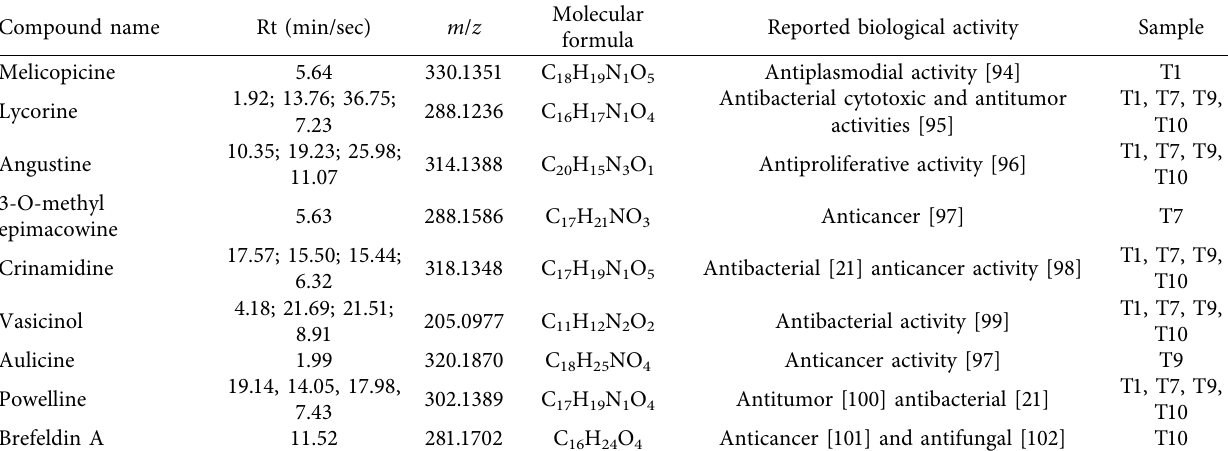
Table 5: LC-Q-TOF-MS analysis of crude extracts of C. macowanii leaves and their bacterial